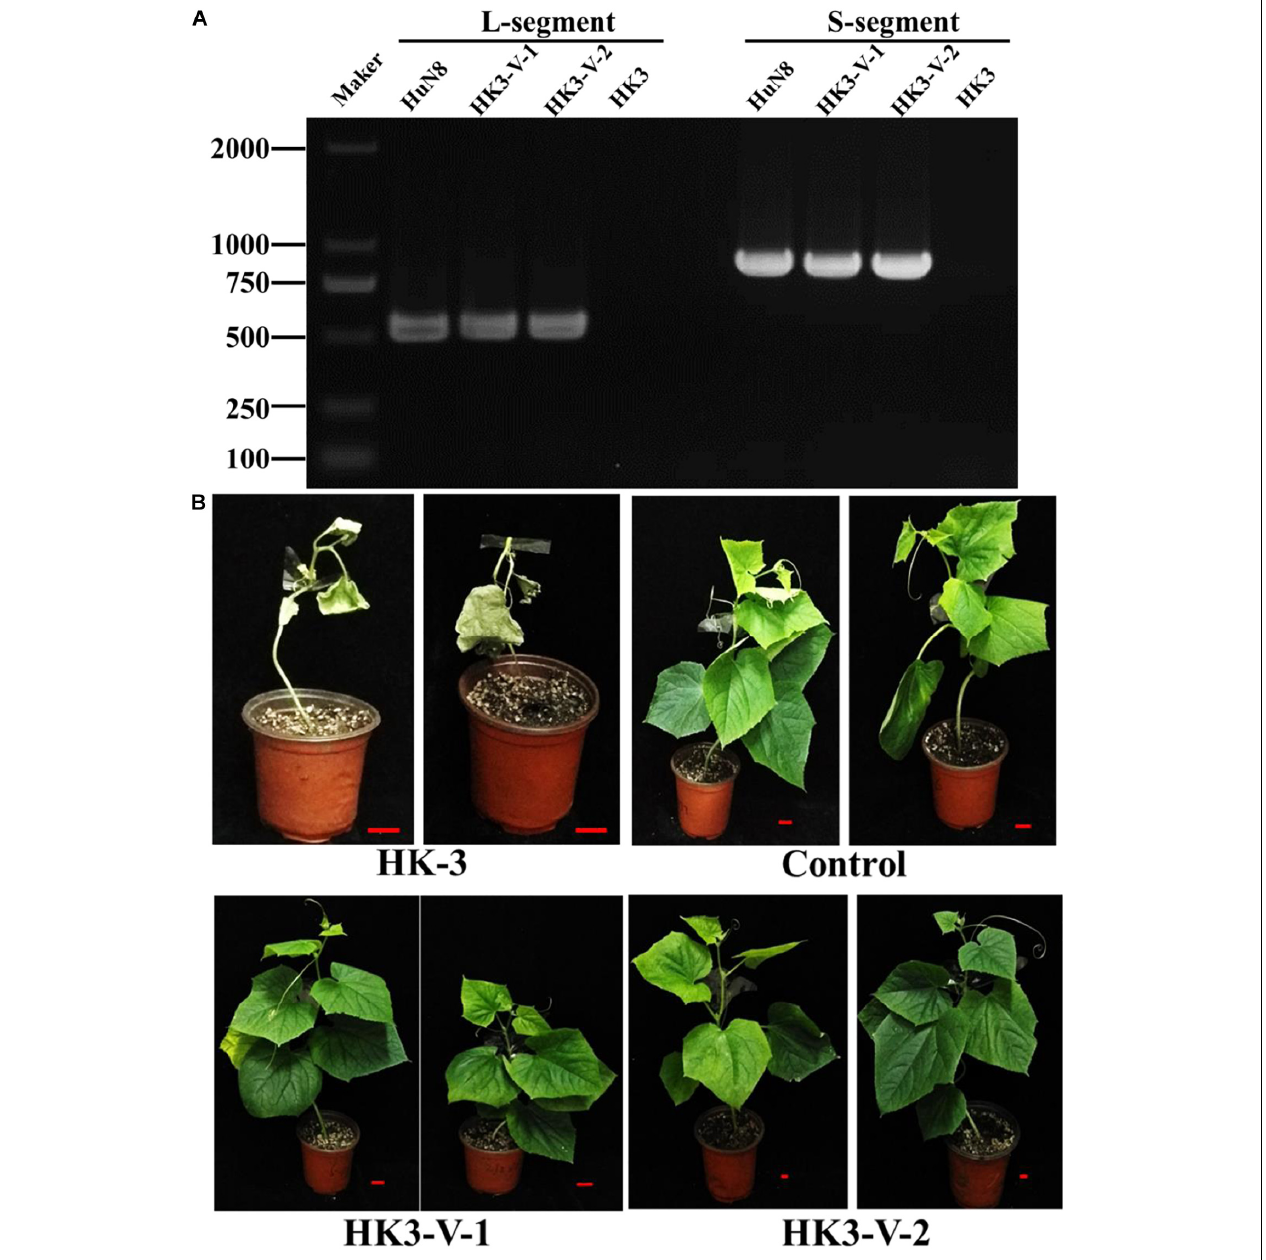
FIGURE 7 | FoOuLV1 infectivity and pathogenicity in FoC strains. (A) Detection of L- and S-segments by RT-PCR. (B) Pathogenicity detection in living cucumber seedlings. HuN8 is the FoM strain (with FoOuLV1), HK3 is the mycovirus-free FoC strain, HK3-V-1, and HK3-V-2 are the FoC derivative strains obtained from the dual-culture technique with strains HuN8 and